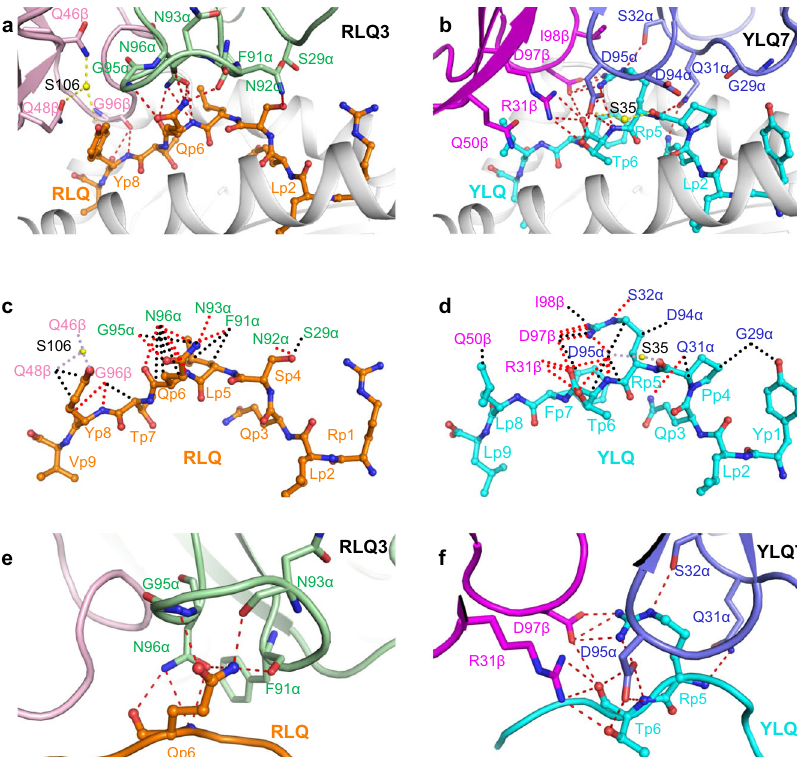
Fig. 6 Interactions of SARS-CoV-2-speci fi c TCRs with the RLQ and YLQ peptides. a Interactions between TCR RLQ3 and the RLQ peptide. The side chains of contacting residues are shown in stick representation with carbon atoms in green (TCR α chain), pink (TCR β chain), or orange (RLQ), nitrogen atoms in blue, oxygen atoms in red, and water molecules as yellow spheres. Peptide residues are identi fi ed by one-letter amino acid designation followed by position (p) number. Hydrogen bonds are indicated by red dashed lines. Water-mediated hydrogen bonds are drawn as yellow dashed lines. b Schematic representation of RLQ3 – RLQ interactions. Hydrogen bonds are red dotted lines, water-mediated hydrogen bonds are yellow dotted lines, and van der Waals contacts are black dotted lines. For clarity, not all van der Waals contacts are shown. c Close-up of interactions of RLQ3 with P6 Gln of the RLQ peptide. d Interactions between TCR YLQ7 and the YLQ peptide (cyan). TCR α chain, blue; TCR β chain, magenta. e Schematic representation of YLQ7 – YLQ interactions. f Close-up of interactions of YLQ7 with P5 Arg and P6 Thr of the YLQ